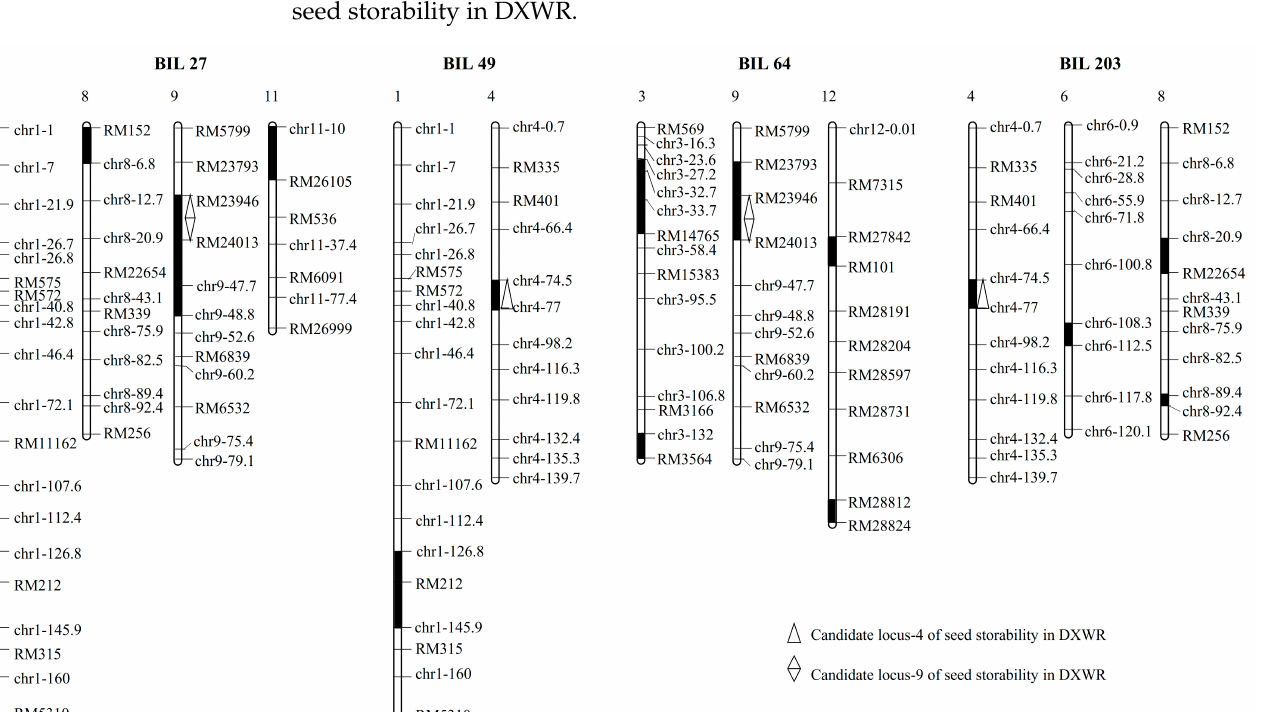
Figure 4. Germination rates of the parents and the four BILs after aging treatment. ( a ) Comparison of germination rates between DXWR and R974 after aging treatment. ( b ) phenotype chart of DR49 and DR203. ( c ) phenotype chart of DR27 and DR64. ( d ) average germination rates of parents and four BILs after aging treatment. Significant differences are indi ‐ cated by asterisks (Student’s t ‐ test; ** P ‐ value < 0.01). 4. Discussion In agronomy, the seed storability of rice is an important trait owing to its correlation with seed quality and germination [39]. Thus, understanding the mechanisms of seed storability and breeding varieties with high storability is critical for rice production. Seed storability is a complex quantitative trait that is controlled by large numbers of QTLs [40]. Although some progress has been made in traditional QTL mapping, the underlying